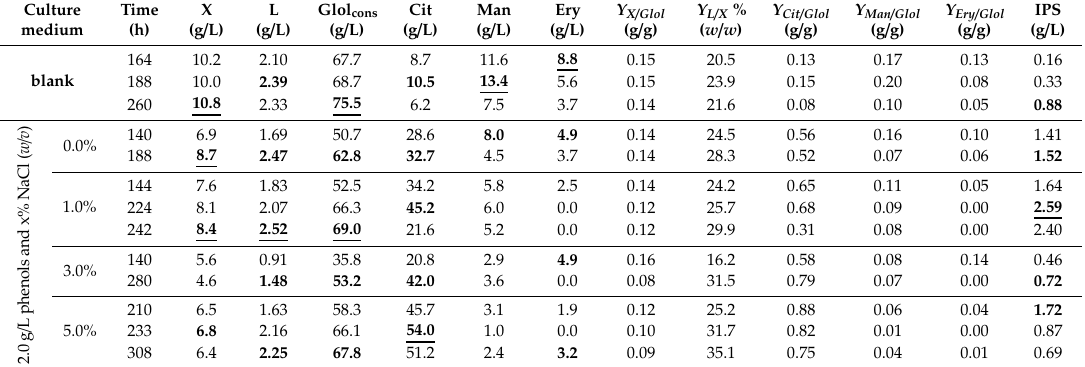
Table 1. values of glycerol consumption, production of biomass, cellular lipids, citric acid, mannitol, erythritol, intra-cellular polysaccharides (IPS) and yield coe ffi cients in culture medium with just glycerol (blank) and glycerol blended with OMWs yielding at initial concentration of 2.0 g / L of phenols using di ff erent concentrations of NaCl w / v (0.0%, 1.0%, 3.0%,